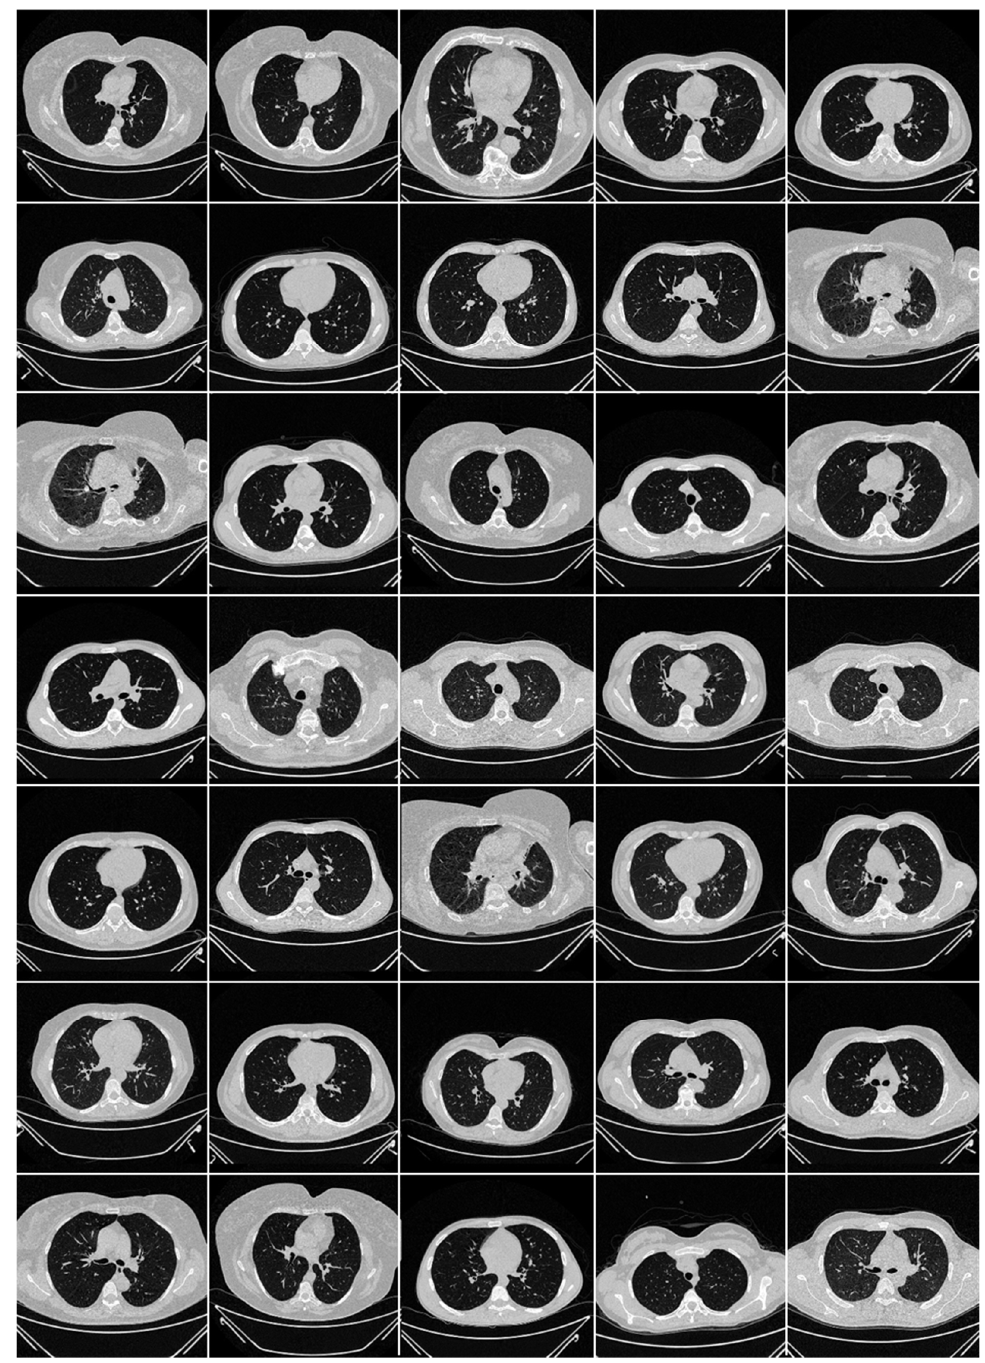
Figure 3. Raw control CT slice taken from Italian data set.